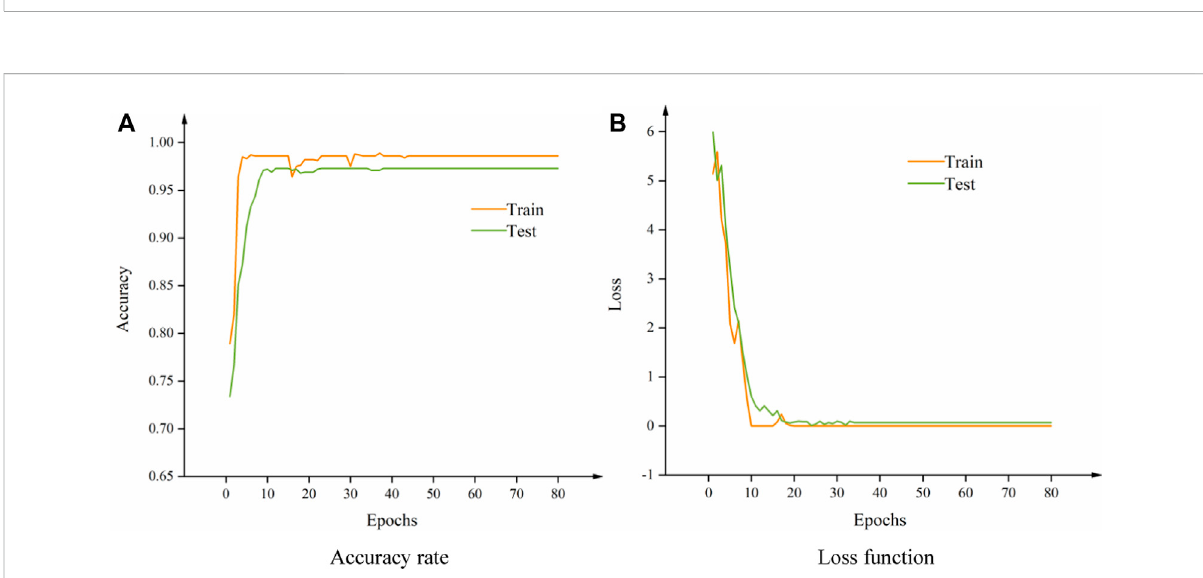
FIGURE 3 5*5 Convolutional training process. (A) Accuracy rate (B) Loss